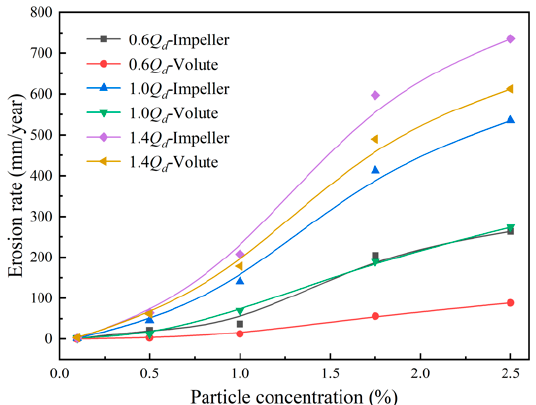
Figure 11. Curves of the erosion rates on the impeller blade and volute with the varying particle concentration under different working flow rates.